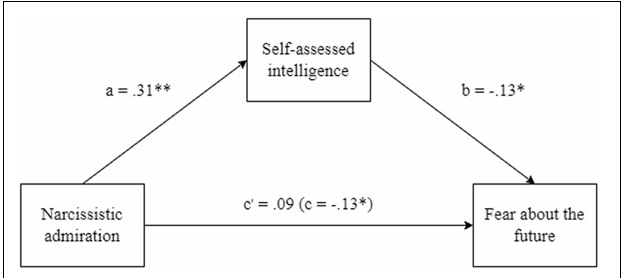
FIGURE 2 | Relationship between narcissistic admiration, fear about the future and self-assessed intelligence. The paths with a and b are direct, c is total effect from narcissistic admiration to fear about the future and c (cid:48) is the direct effect, controlling self-assessed inteligence. ∗ p < 0.05, ∗∗ p <